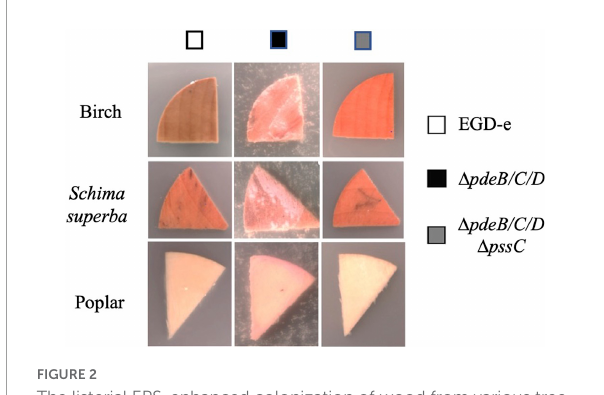
FIGURE2 The listerial EPS-enhanced colonization of wood from various tree species. Coupon pieces from three tree species (birch, Schima superba and poplar) show higher colonization by the L. monocytogenes EPS-synthesizing strain ( (cid:49) pdeB/C/D ), compared to the wild type (EGD-e) and EPS-impaired strain ( (cid:49) pdeB/C/D (cid:49) pssC ). The pink color of the biomass is due to the expressed mScarlet protein. Wood pieces were incubated in the HTM/GY minimal medium in the presence of listeria for 48 h at 30 ◦